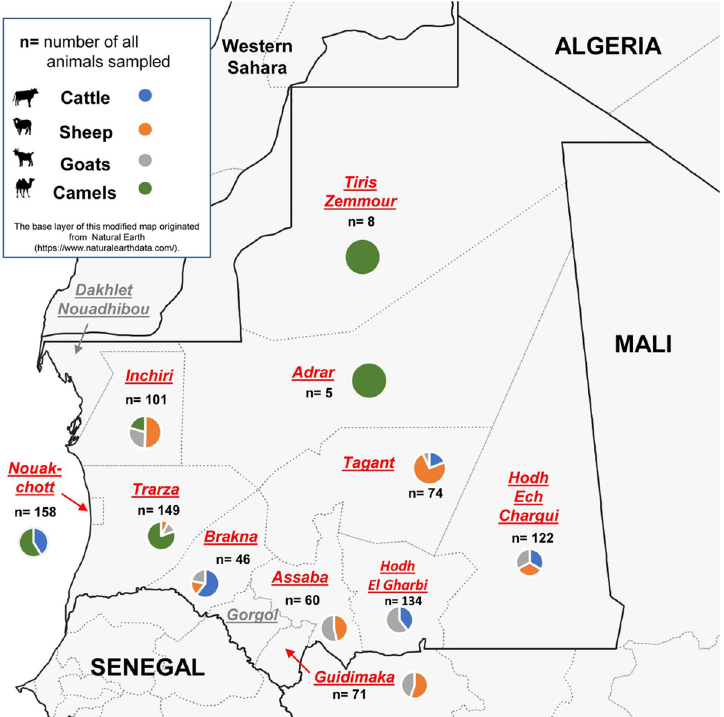
Fig 1. Map of Mauritania which shows the proportion and total number of each different animal species sampled in each region. All sampled regions are highlighted in red. For more detailed information on prevalence and numbers, please refer to Table 1. The base layer of this modified map originated from Natural Earth (https://www. naturalearthdata.com/).